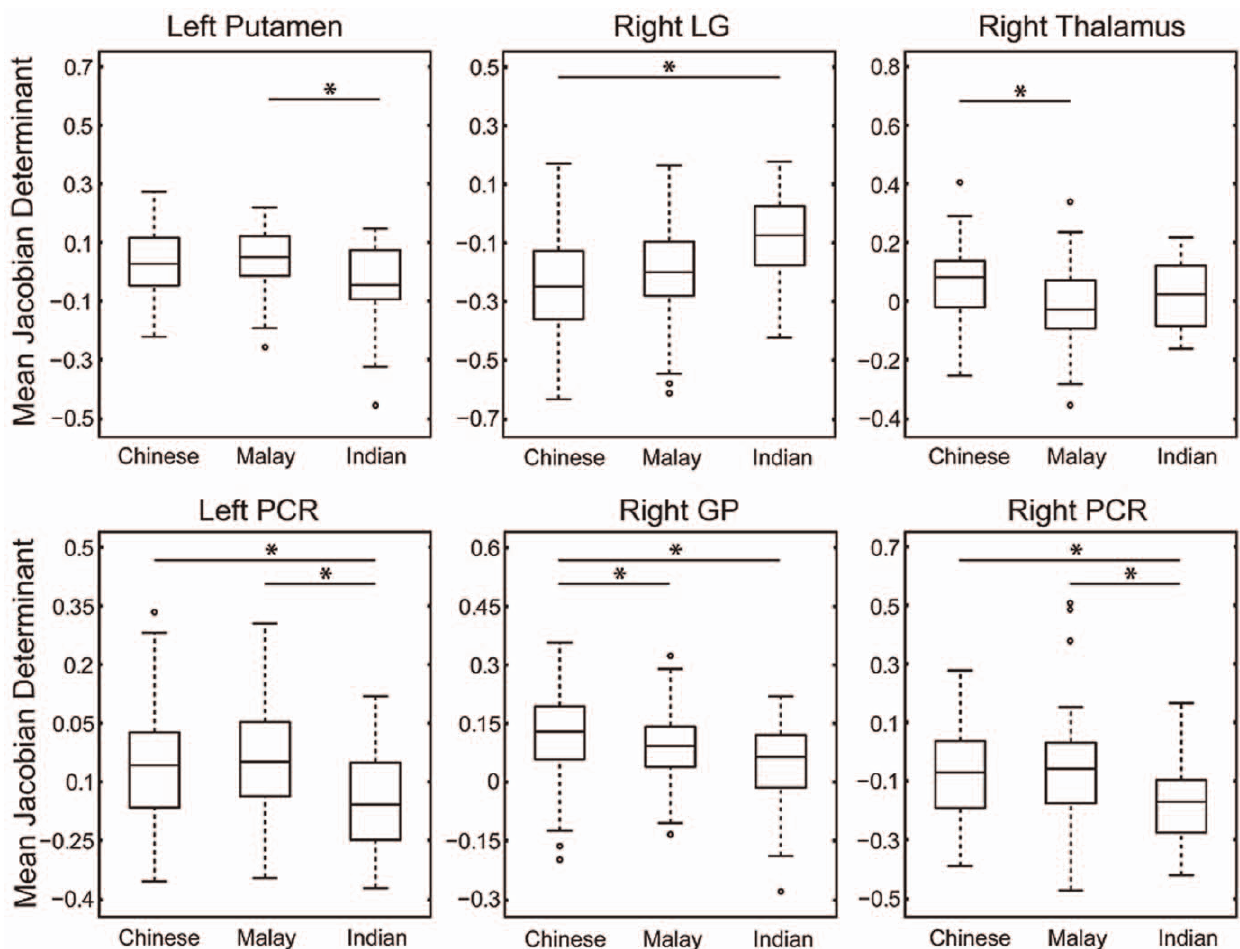
Figure 3. Boxplots of mean deformation within each anatomical region extracted from voxel-based analysis on the brain morphological shape (see Figure 2A). The significant pairwise group differences are indicated using black asterisk.